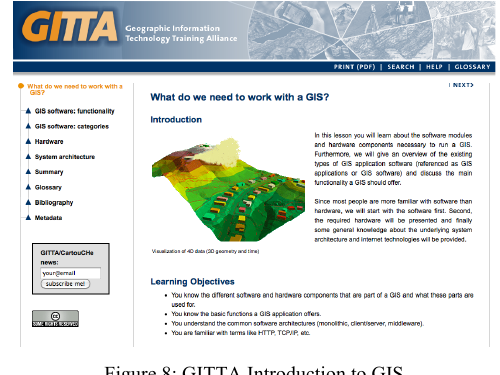
Figure 8: GITTA Introduction to GIS http://www.gitta.info/